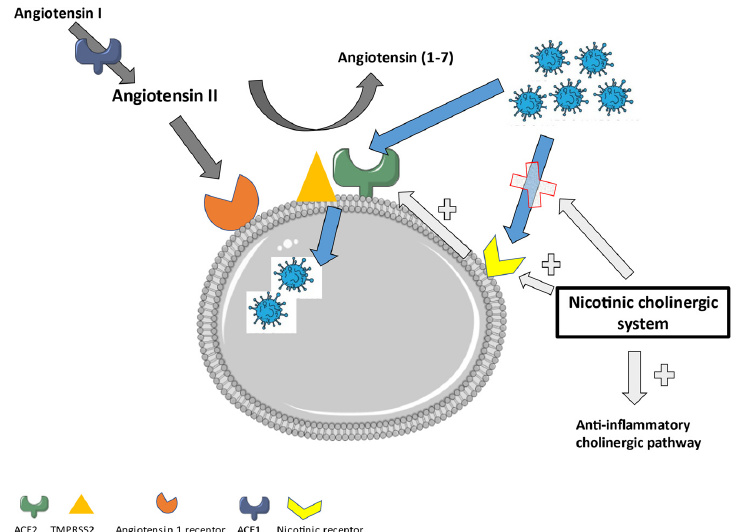
Figure 5. The role of the nicotinic cholinergic system in a SARS-CoV-2 infection .